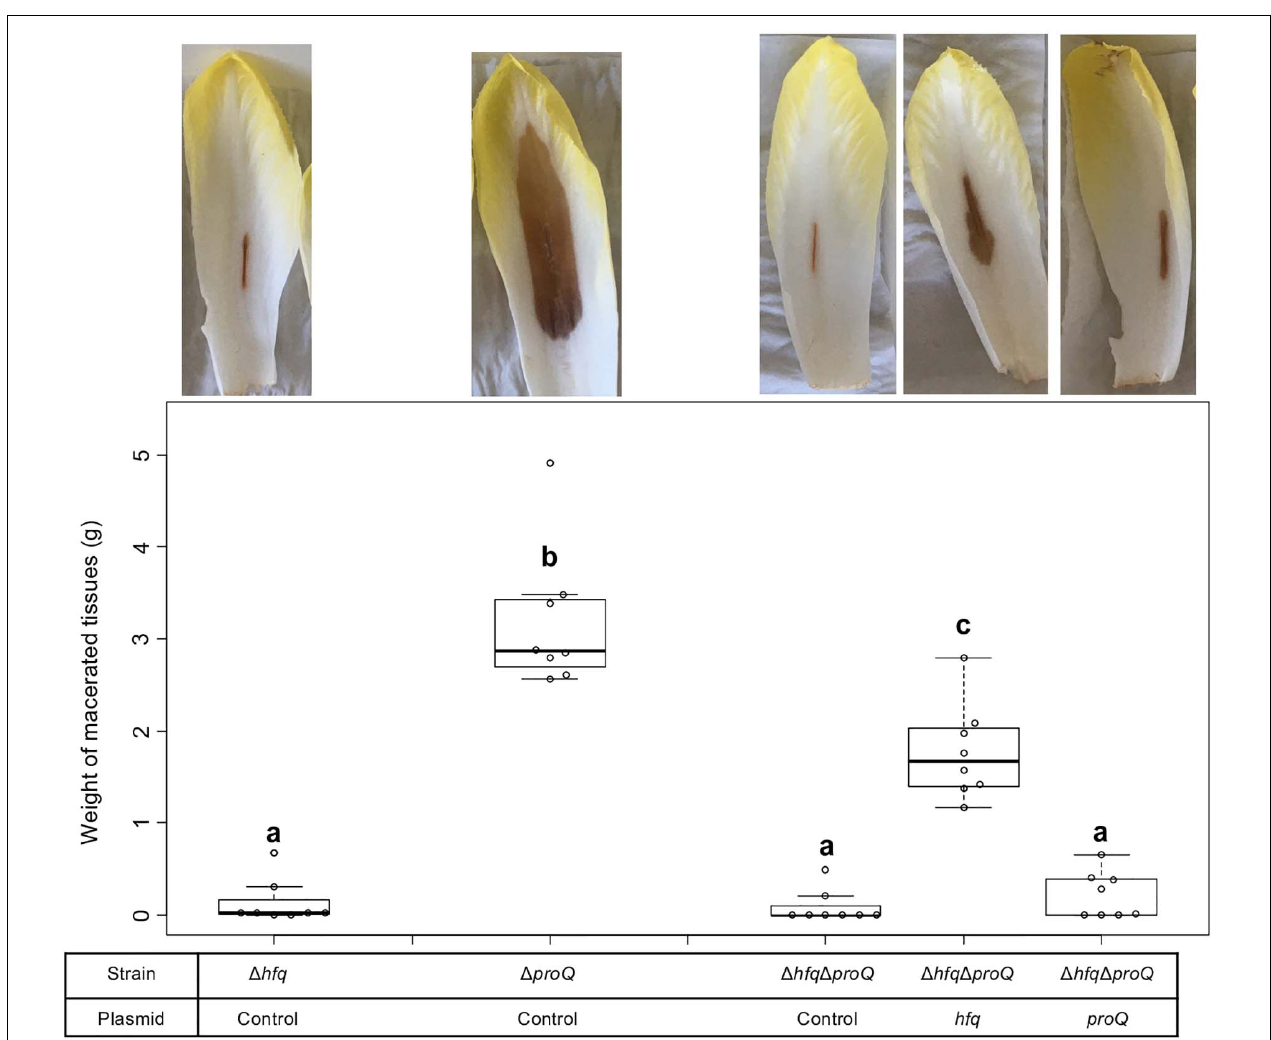
FIGURE 6 | D. dadantii virulence assays 48 h post-infection. Virulence was evaluated on the single mutants, the double mutant, and the double mutant complemented by Hfq or ProQ. Chicory leaf assays were performed as described in the “Materials and Methods” section with an incubation time of 48 h. Representative examples of symptoms induced were shown and the weights of macerated tissues were measured. Experiments were repeated three times with at least seven leaves tested in each replicate. Non-capital letters a, b, and c are presented above the boxplots. Groups with the same letter are not detectably different (are in the same set) and groups that are detectably different get different letters (different sets). Note that if the groups have the same letter, this does not mean they are the same, just that there is no evidence of a difference for that pair ( P < 0.05, Wilcoxon Mann-Whitney